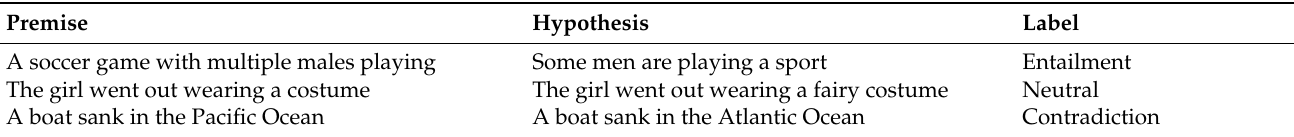
Table 1. Examples of NLI sentence pairs and their